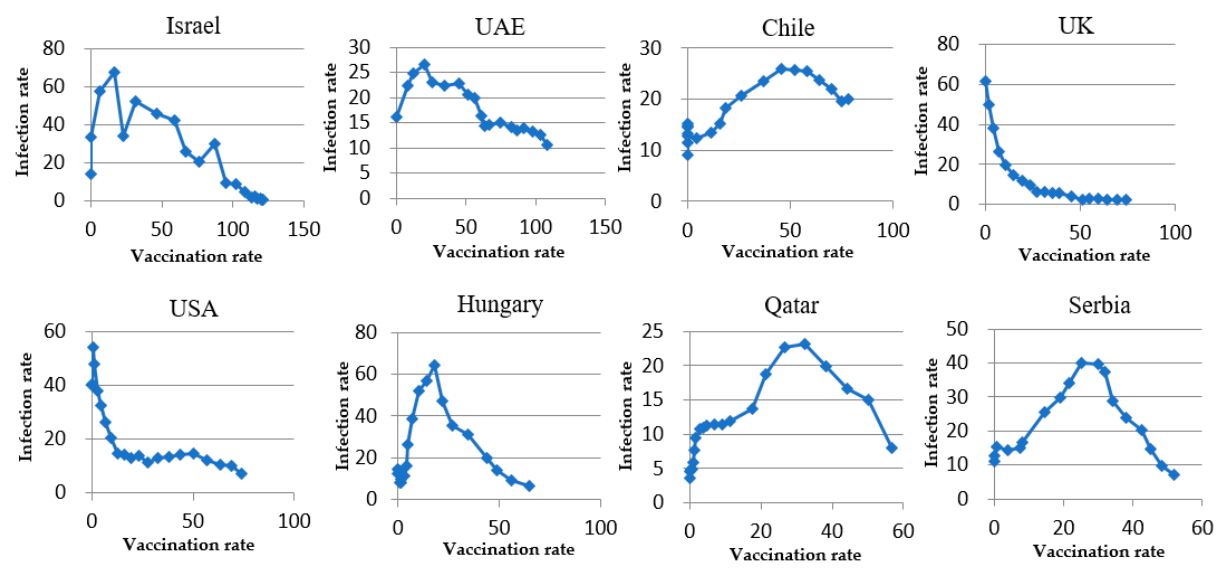
Figure 1. The scatter diagram of vaccination rates vs. infection rates (2 weeks later) for each country.